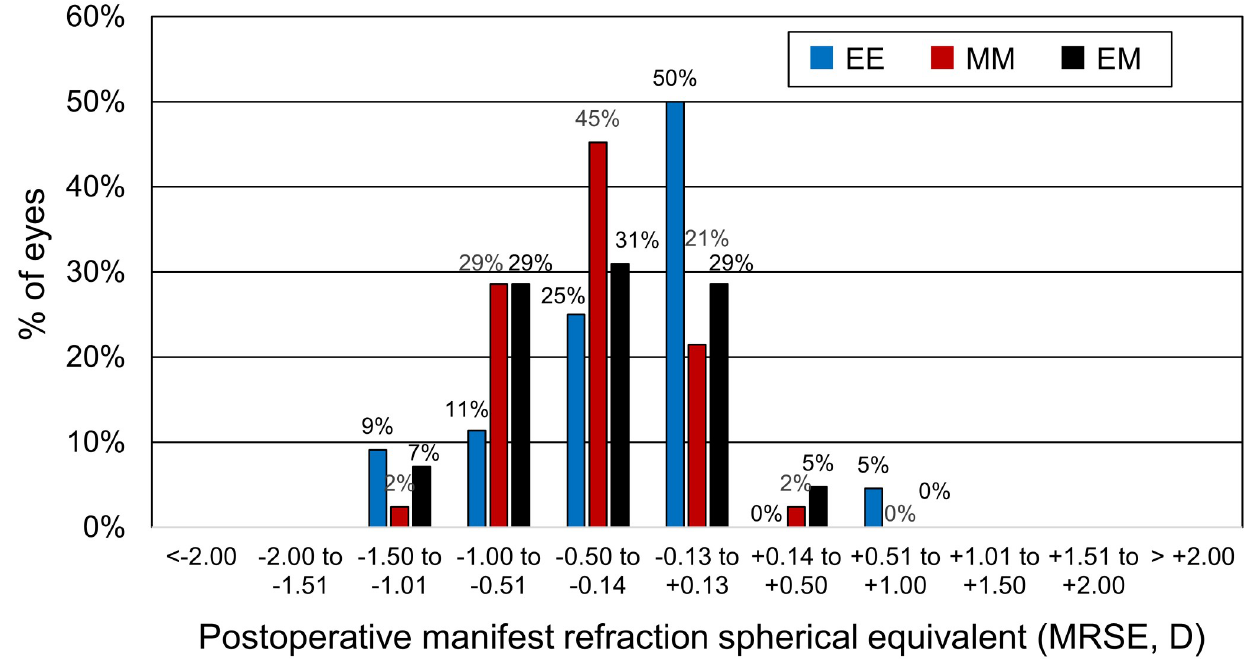
Fig 2. Histograms of postoperative manifest refraction spherical equivalent in three groups. Group EE: bilateral emmetropia, group MM: bilateral -0.5 diopters, and Group EM: monovision of emmetropia and -0.5 D.